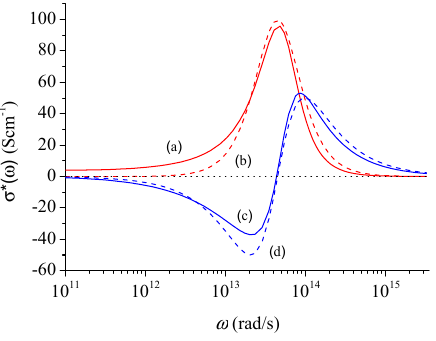
Figure 9. Complex conductivity predicted from the SSFTC, solid lines ( a ) and ( c ), where n = 4.5 × 10 18 cm − 3 , n t = 4.0 × 10 19 cm − 3 , f = 0.70, τ = 2.0 × 10 − 14 s, and τ t = 4.0 × 10 − 12 s are used. Dashed lines, ( b ) and ( d ), are from the Lorentz resonance, where N = 4.5 × 10 18 cm − 3 , ω p = 4.5 × 10 13 s − 1 , and τ L = 1.3 × 10 − 13 s.